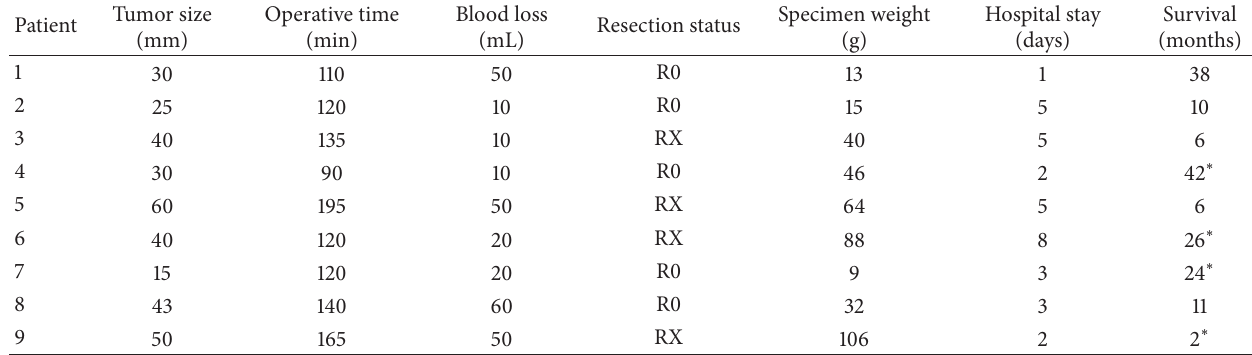
Table 2: Perioperative and postoperative